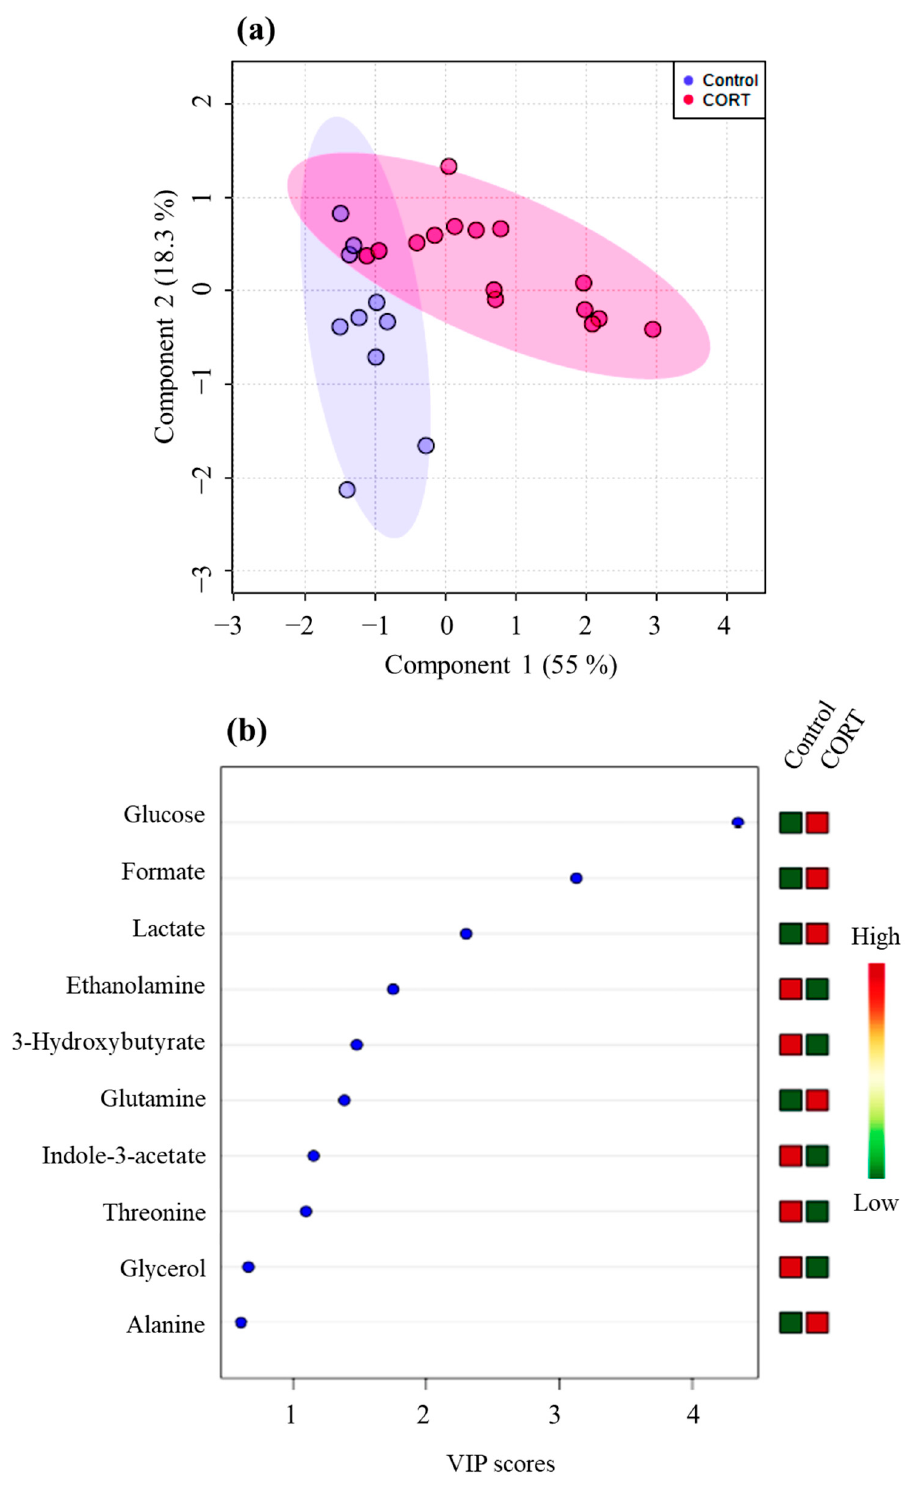
Figure 3. Partial least squares discriminant analysis (PLS-DA) scores plot ( a ) and corresponding variable importance in projection (VIP) score plot for D2 for component 1 ( b ) on D2 for serum of lesser scaup ( Aythya affinis ) that received either a CORT pellet (CORT) or a placebo (control). Numbers in parenthesis in axes of the PLS-DA score plot indicate the percentage of the variance explained by a corresponding component. In the VIP plot, metabolites with a VIP score > 1 are significant (i.e., VIP metabolites). The coloured boxes to the right of the VIP plot indicate which group had higher (red) vs. lower (green) levels of each metabolite compared to the other group.